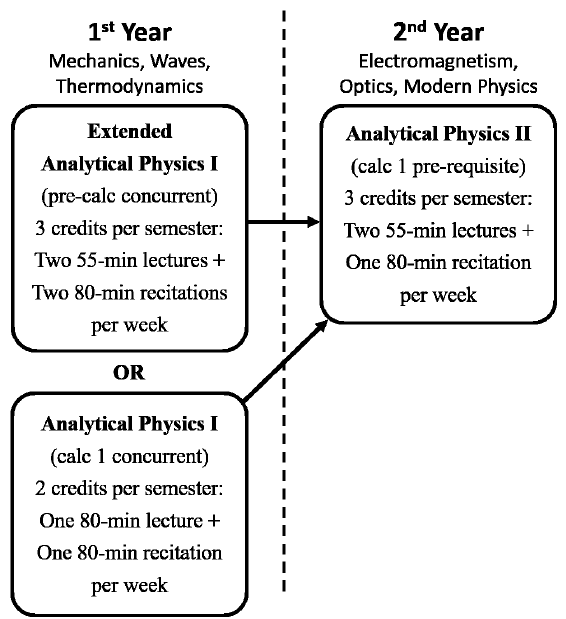
FIG. 1. The two-year Analytical Physics sequence, adapted from Ref.